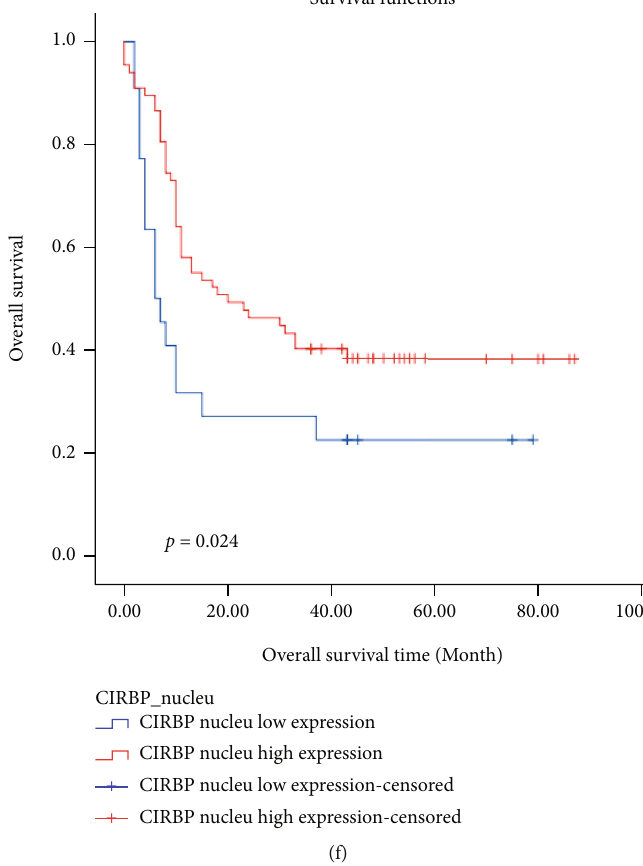
Figure 1: The expression level of CIRBP in pancreatic cancer. (a) The online database GEPIA2 showed the expression level of CIRBP in di ff erent tumors. (b) Data from database GEPIA2 showed the expression level of CIRBP in pancreatic cancer. (c) Survival curve analysis was performed using the expression data of CIRBP in database GEPIA2. (d) The expression level of CIRBP in the cytoplasm of cancer tissues was signi fi cantly lower than that of adjacent tissues. ∗∗∗∗ P < 0 : 0001 versus tumor. (e) The expression level of CIRBP in pancreatic cancer tissues was detected by immunohistochemistry. (f) Survival curve was analyzed according to the expression level of CIRBP in pancreatic cancer